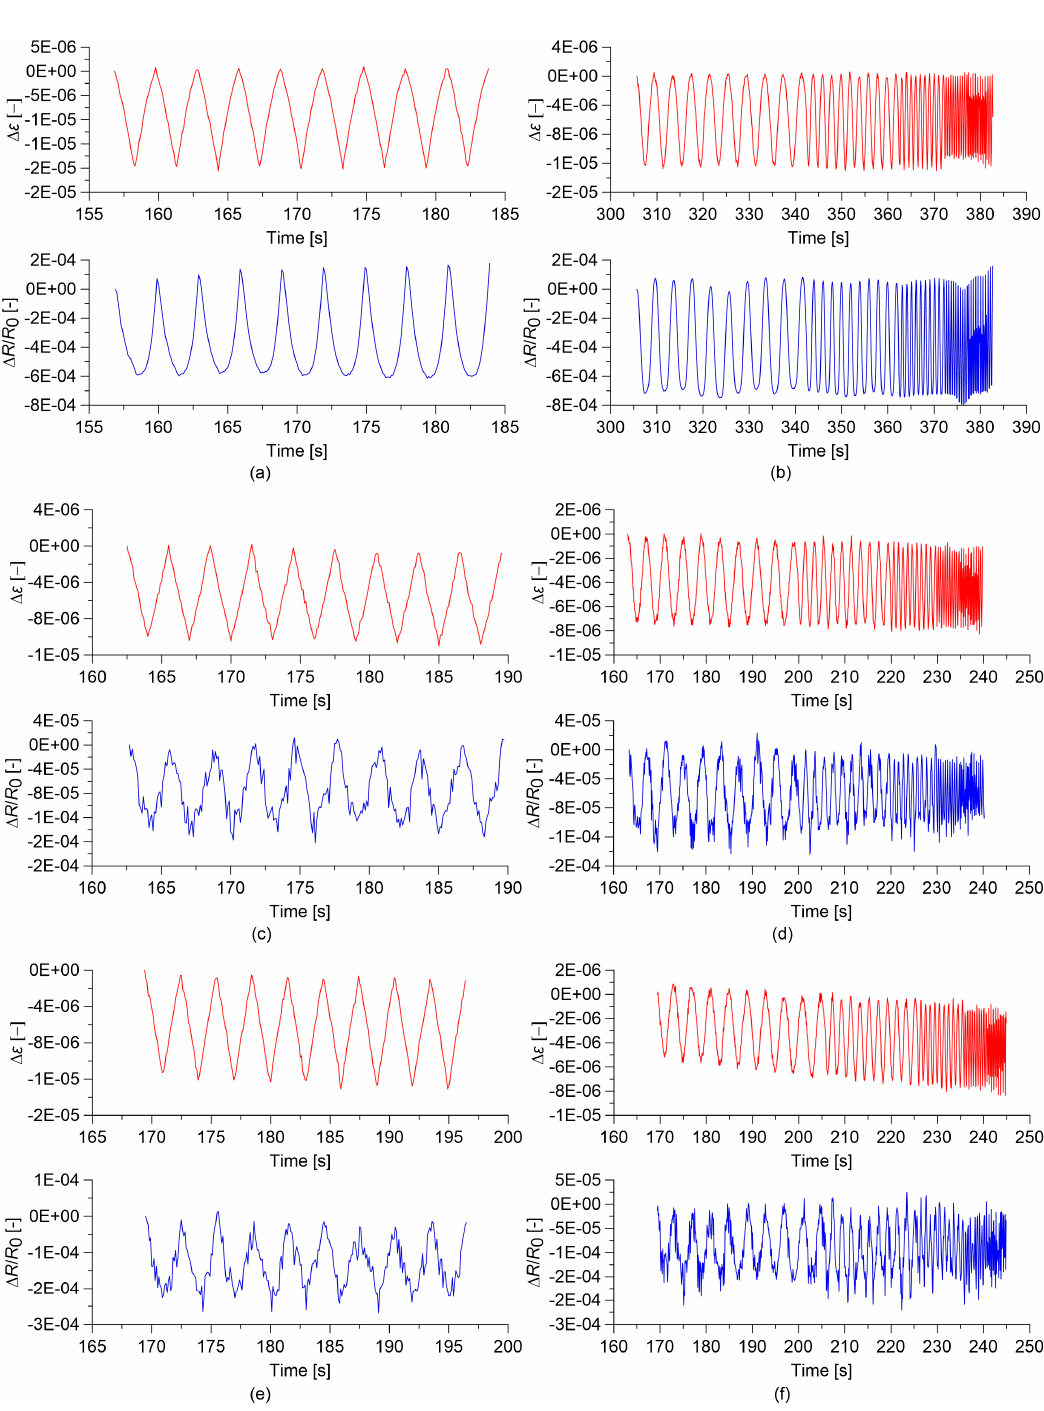
Figure 9. Time histories of the relative change in electrical resistance, Δ R/R 0 , and of the applied strain, Δ ε , obtained from the electromechanical tests. In the plots, R 0 is the electrical resistance value with a preload of 0.5 kN: ( a ) Quasi-static load applied on concrete with 0.00% MWCTs; ( b ) Sine-sweep dynamic load applied on concrete with 0.00% MWCNTs; ( c ) Quasi-static load applied on concrete with 0.50% MWCNTs; ( d ) Sine-sweep dynamic load applied on concrete with 0.50% MWCNTs; ( e ) Quasi-static load applied on concrete with 1.00% MWCNTs; ( f ) Sine-sweep dynamic load applied on concrete with 1.00% MWCNTs.